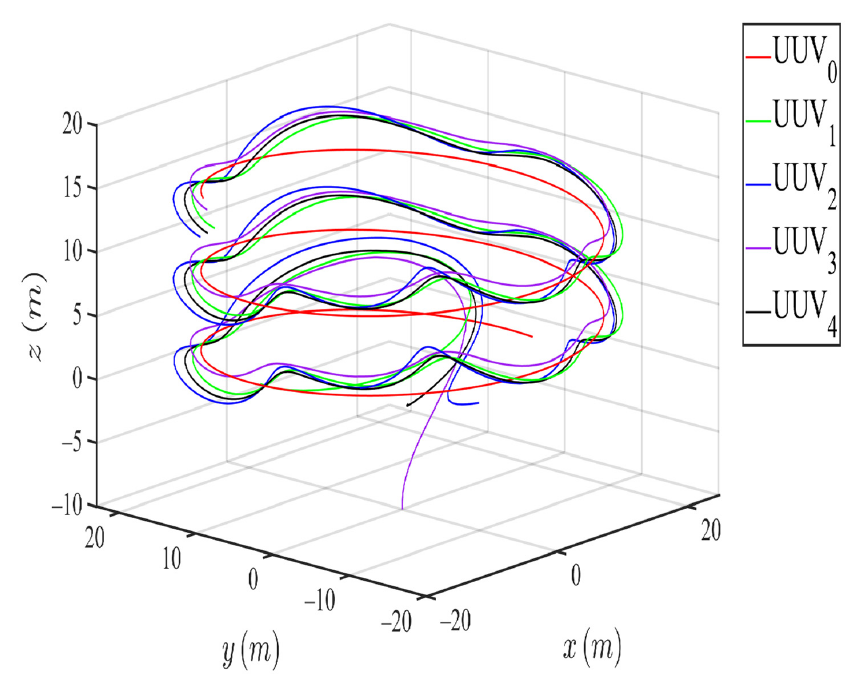
Figure 4. 3D trajectories of UUVs without disturbance observer.